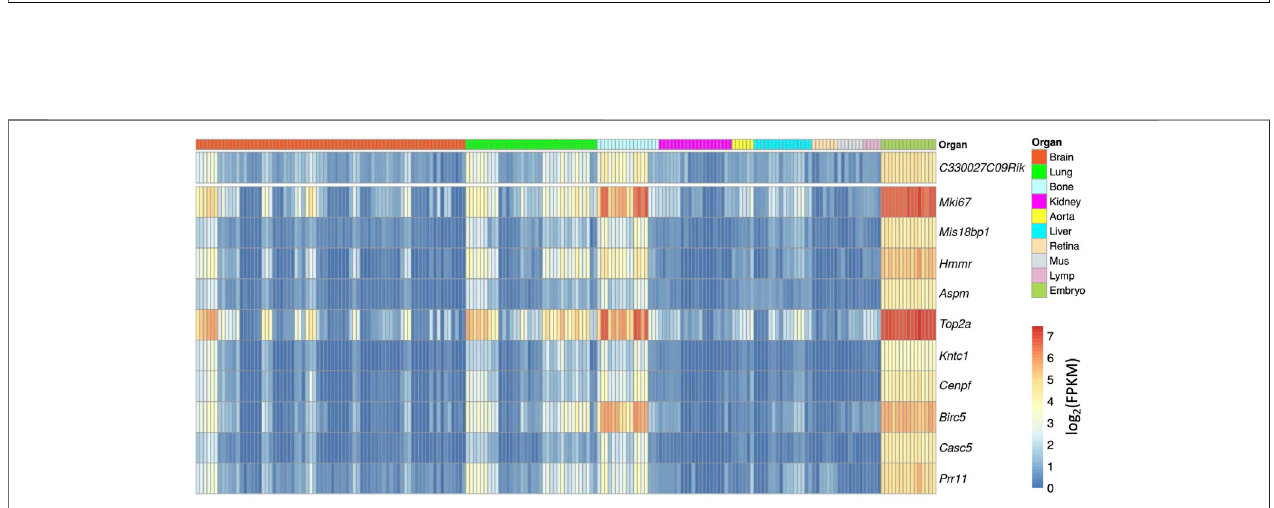
FIGURE 3 | Sele regulation in different conditions. The x -axis shows the 40 conditions, and the y -axis shows the log2 scaled regulation fold change (logFC). Each bar shows the average fold change with con fi dence interval in each condition. The bars are colored according to their organ origins (high-resolution image is available in the ECO online database).